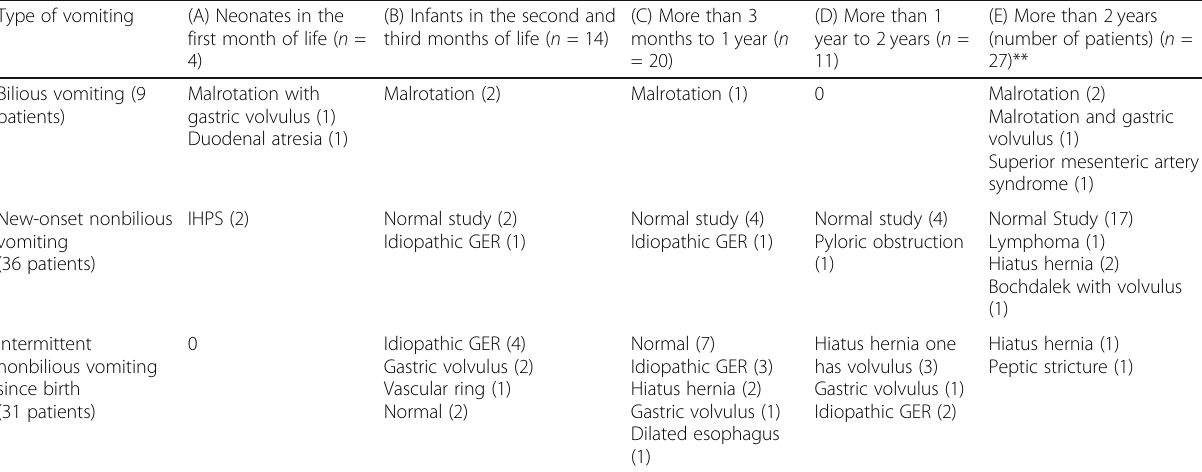
Table 1 Imaging findings in different age groups in different clinical scenarios Type of